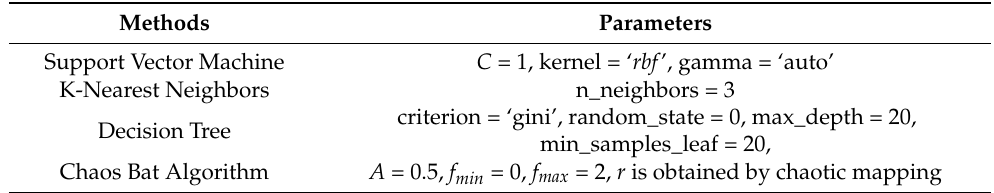
Table 2. Parameters for the base